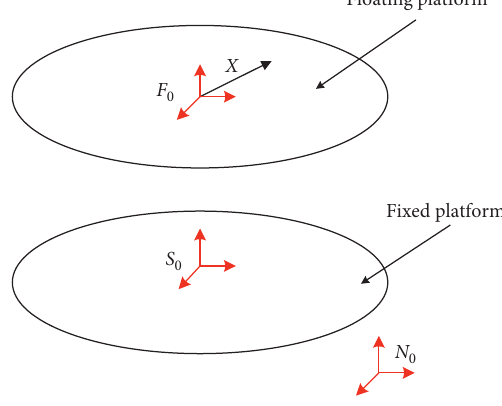
Figure 3: Coordinate system